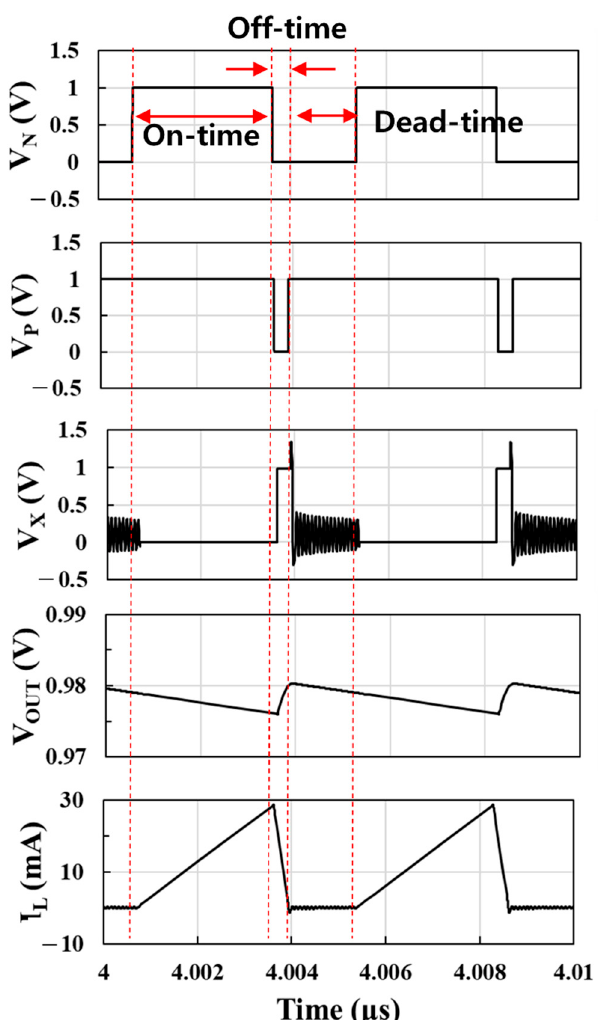
Figure 12. Waveforms of the switch control signals V N and V P , internal node voltage V X , inductor current I L , and output voltage V OUT for an input voltage of 0.1 V.